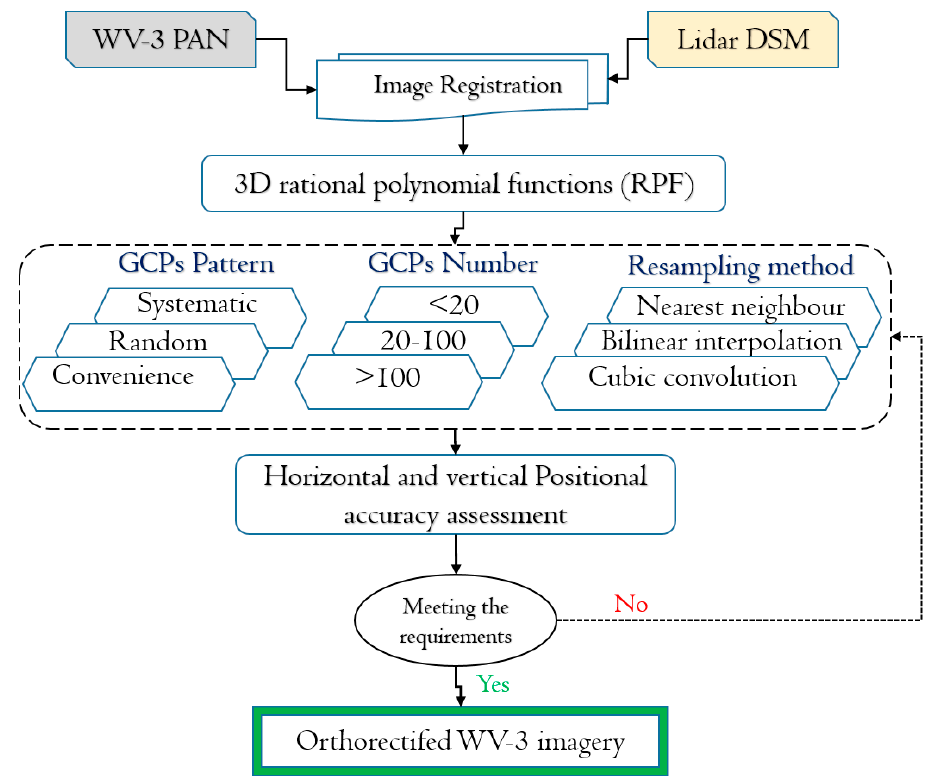
Figure 2. Overall flowchart of this study.